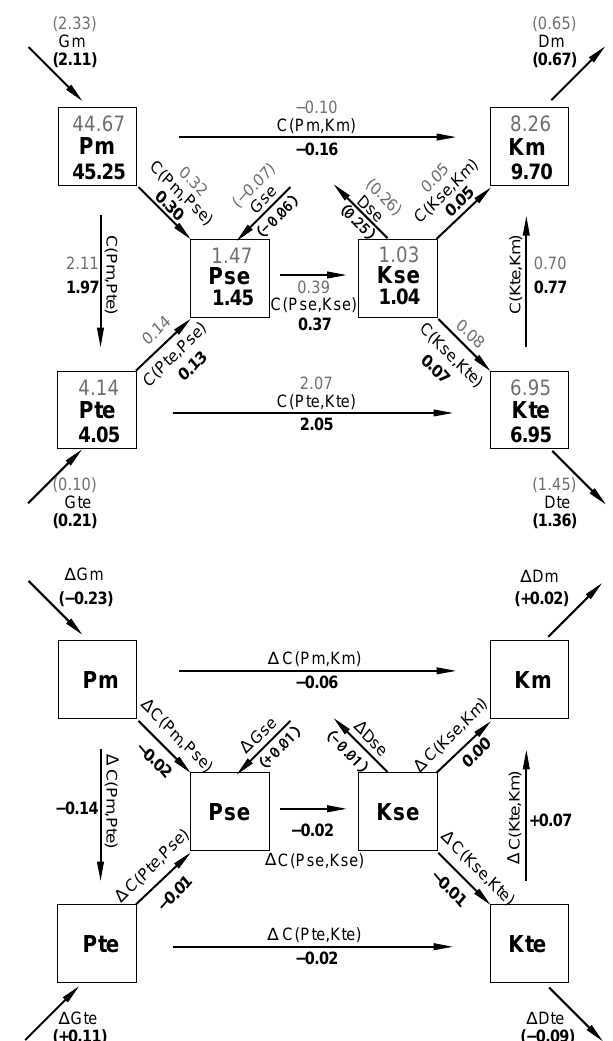
Fig. 5. 6-box LEC diagram (after transient and stationary eddy de- composition). Upper panel shows values for the 1 × CO 2 (above, gray) and 2 × CO 2 (below, black) experiments. Generation and dis- sipation rates (in parenthesis) are obtained as residuals. Lower panel shows the 2 × CO 2 changes in energy generation, conversion and dissipation rates. Units are 10 5 Jm − 2 for reservoirs and Wm − 2 for conversion, generation and dissipation terms. Arrows indicate the direction corresponding to positive values; negative values imply opposite